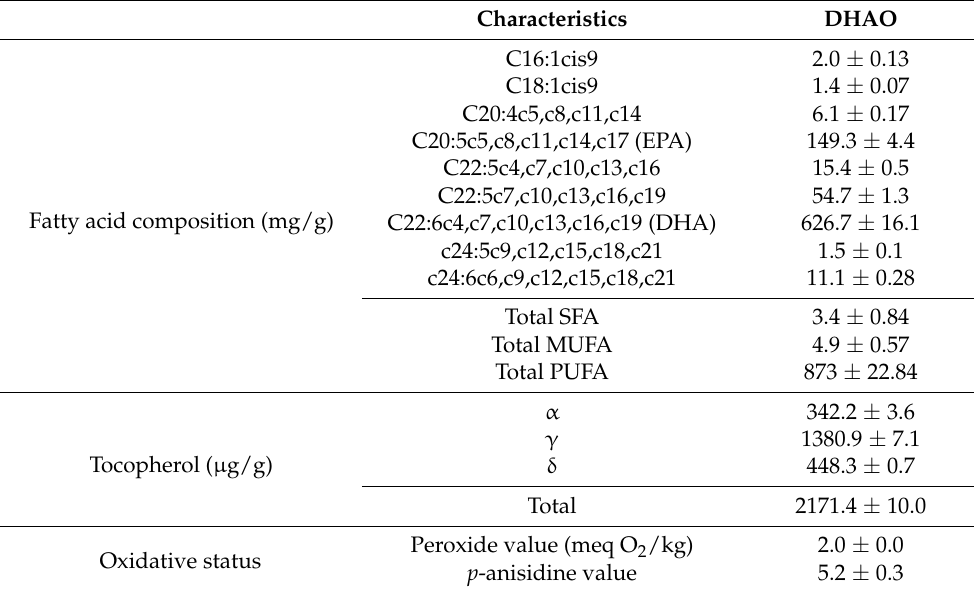
Table 1. Fatty acid composition, tocopherol content and oxidative status of DHA-rich oil (DHAO).